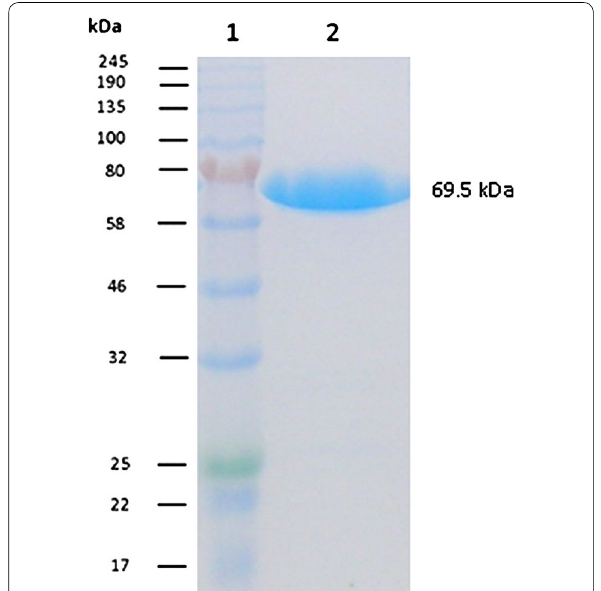
Fig. 1 SDS-PAGE analysis of purified laccase expressed in E. coli . Lane 2 was loaded with 13 µg of protein and the gel was stained